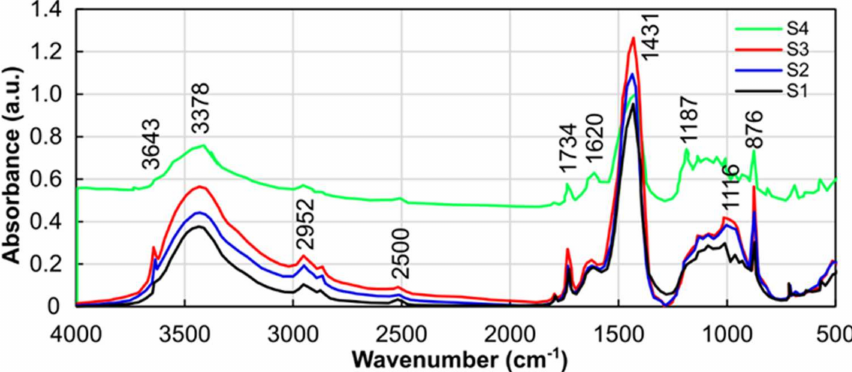
Figure 9. FTIR curves of the samples